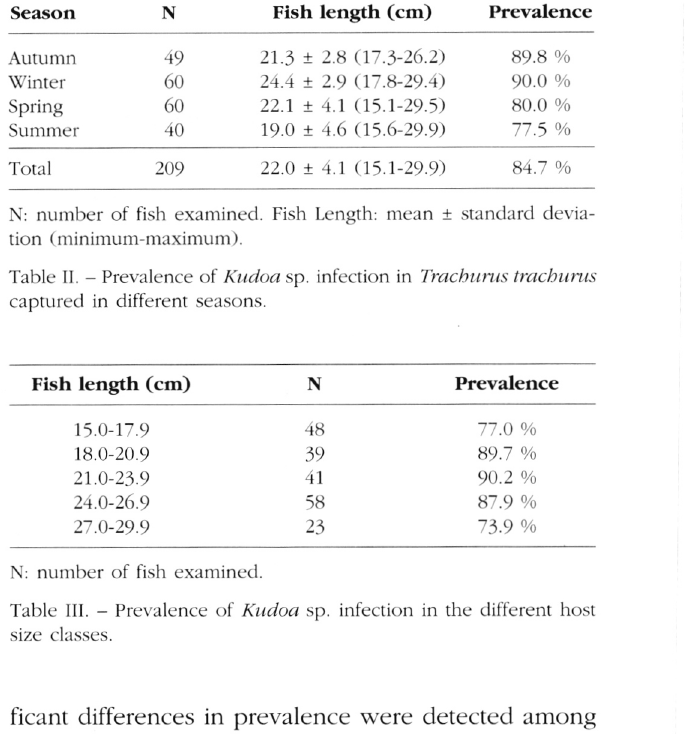
Table III. - Prevalence of Kudoa sp. infection in the different host size classes.